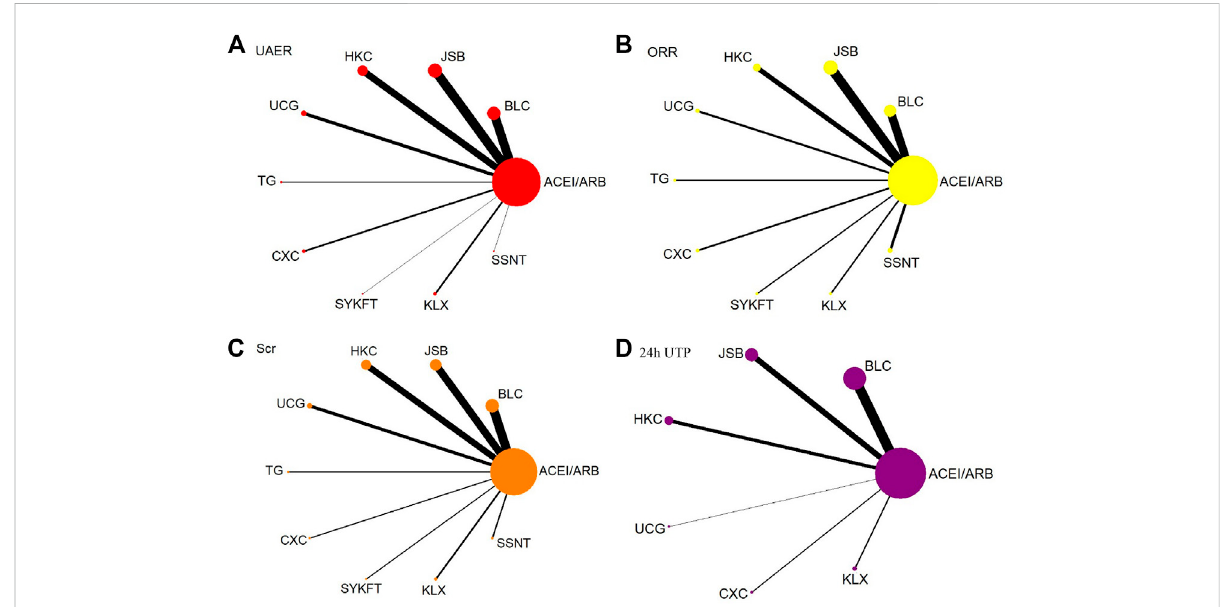
FIGURE 2 Network diagrams of primary outcomes. BLC, Bailing capsule; JSB, Jinshuibao capsule; HKC, Huangkui capsule; UCG, uremic clearance granule; TG, tripterygium glycosides; CXC, Compound Xueshuantong capsule; SYKFT, Shenyan Kangfu tablet; KLX, Keluoxin capsule; SSNT, Shenshuaining tablet; ACEI, angiotensin-converting enzyme inhibitor; ARB, angiotensin receptor blocker; UAER, urinary albumin excretion rate; ORR, overall response rate; Scr, serum creatinine; 24 h UTP, 24 h urinary total